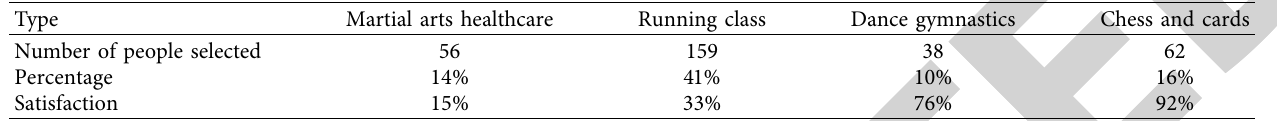
Table 3: Proportion of selected sports and fitness items for the elderly in urban communities ( n � 210).